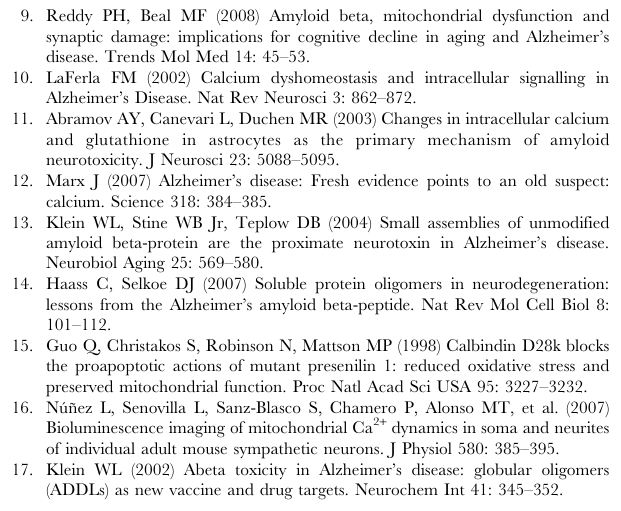
Figure S4 A b oligomers induce ROS formation that